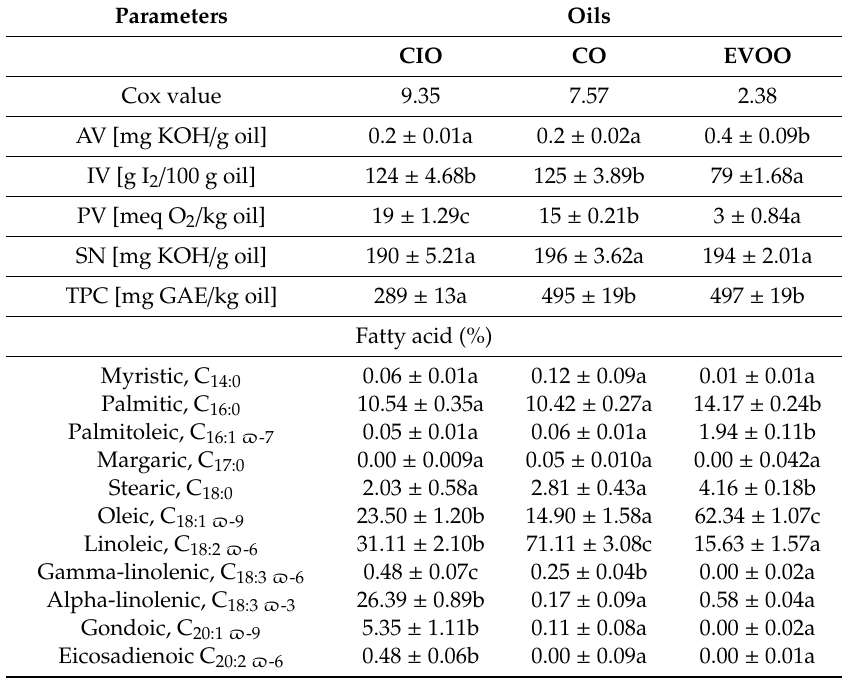
Table 1. Chemicalcompositionandfattyacidcompositionof Colliguayaintegerrima (CIO), Cynaracardunculus (CO), and extra-virgin olive (EVOO) oils. The results were expressed as mean values ± SDs ( n = 3). Values in the same Same letter (a,b,c) beside standard deviation (SD) in the same row indicate no statistical differences between the oils, using Tukey HSD (at 95% level of